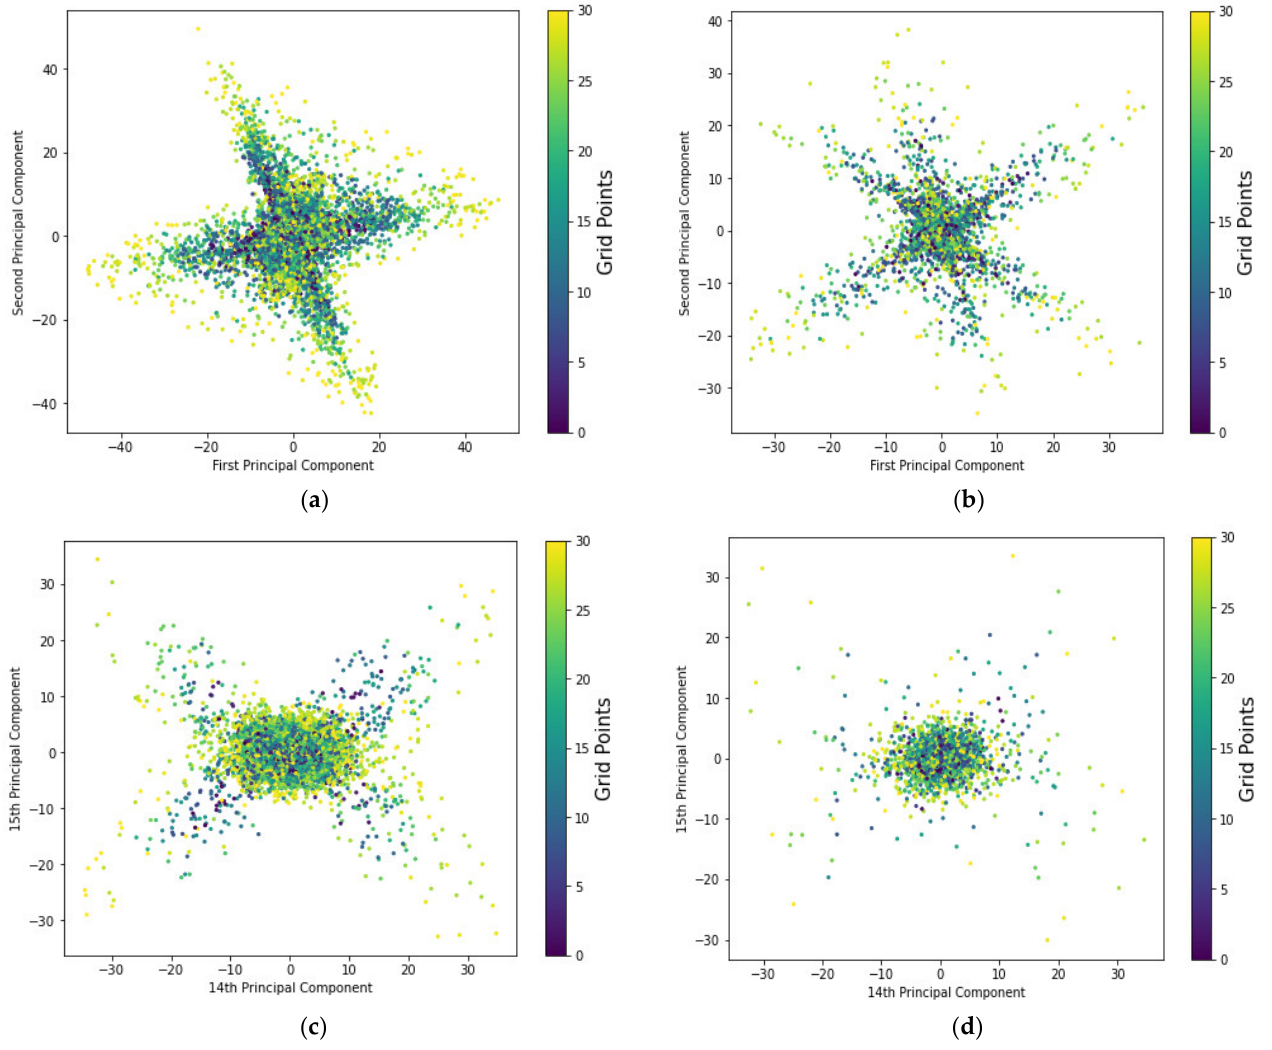
Figure 6. Distribution of principal components of datasets collected during month 1 with their corresponding RPs. ( a ) Training dataset Day1M1, ( b ) Testing dataset Day1M1, ( c ) Training dataset Day1M1, ( d ) Testing dataset